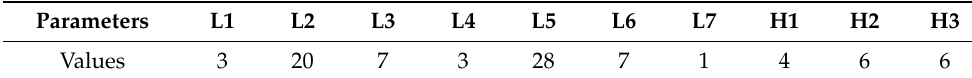
Figure 4. Parameters of the stator. Table 1. Parameters of the stator (unit: mm).